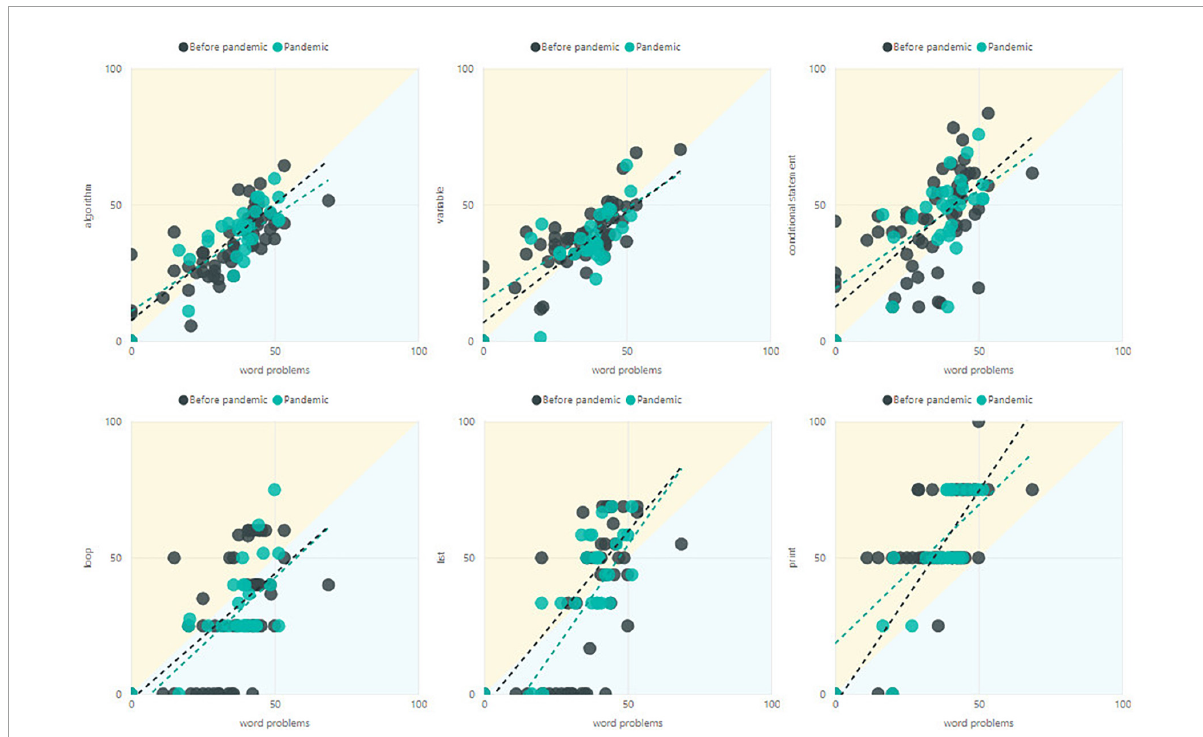
FIGURE4 Correlation between word problems and algorithm, and word problems and all the programming